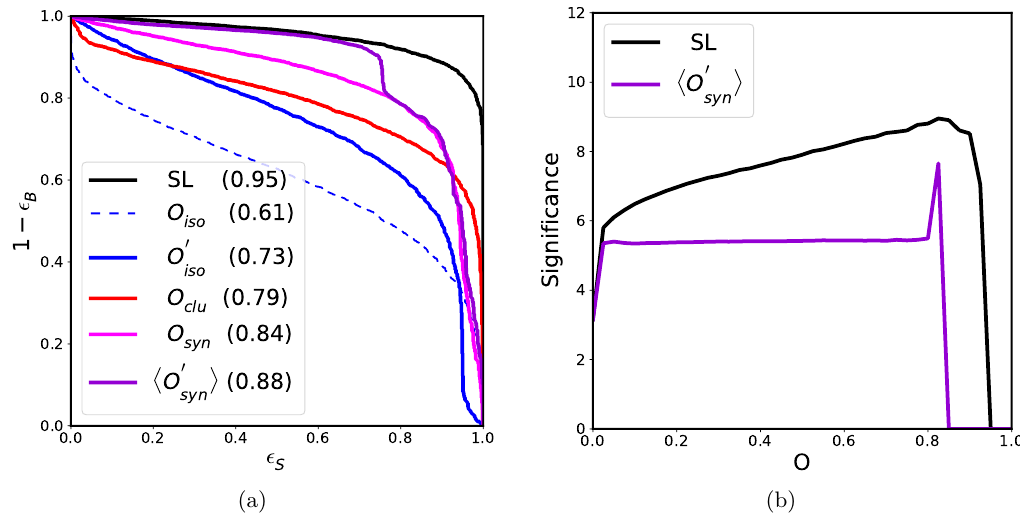
Figure 11 . (a) ROC curves and their AUC values (given in brackets) for the set of R AE -based novelty evaluators considered and (b) statistical significance as a function of the novelty score threshold (40 bins are defined), applied to the 2D Gaussian testing samples corresponding to BP 5. Here r = 0 . 6 is taken to define the signal-like sample S 0 for training O 0 0 performance has also been reported.